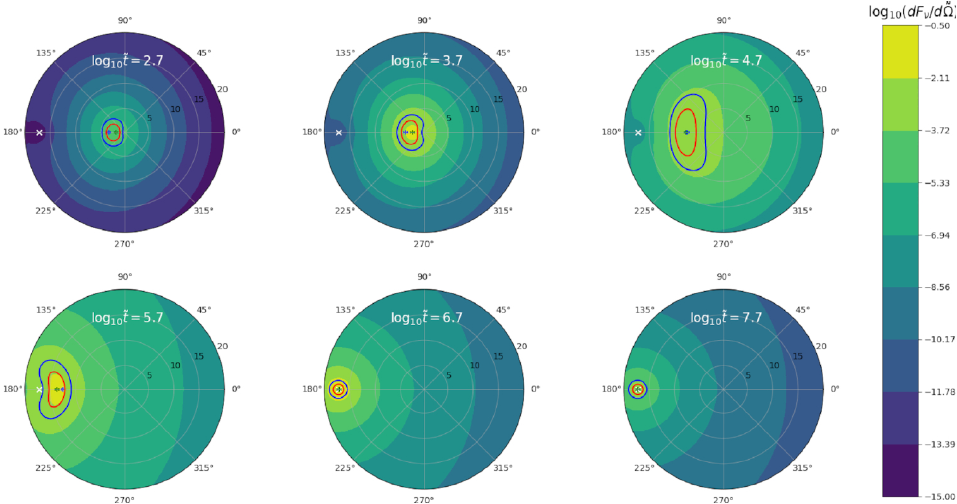
Figure 9. Angular map showing the intensity distribution per unit solid angle (color coded) of emission from the afterglow forward shock, centered on the line of sight. The position of the jet axis is marked by the white cross symbol. The green cross and red (blue) contours show the peak of the intensity and the region containing 50 (80%) of the total flux. A power-law structured jet with core values Γ c = 1000 and θ c = 0.03 rad is considered. The power-law slopes are a = 4 and b = 2 for the energy and Γ structure, the observer viewing angle is 10 times the core opening angle and the external medium density is constant. The maps correspond to different observing times (as measured in the rest frame of the central engine), from 500 s ( top left ) to 580 days ( bottom right ). Reproduced from